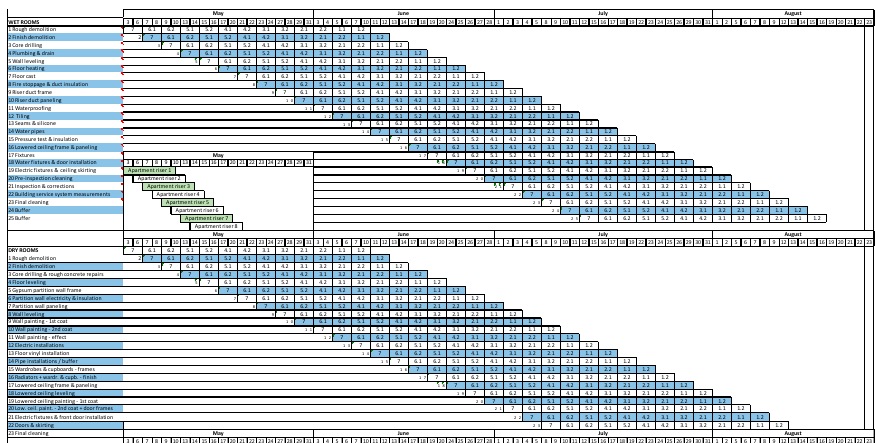
Figure 4. The takt schedule drafted for the case project.